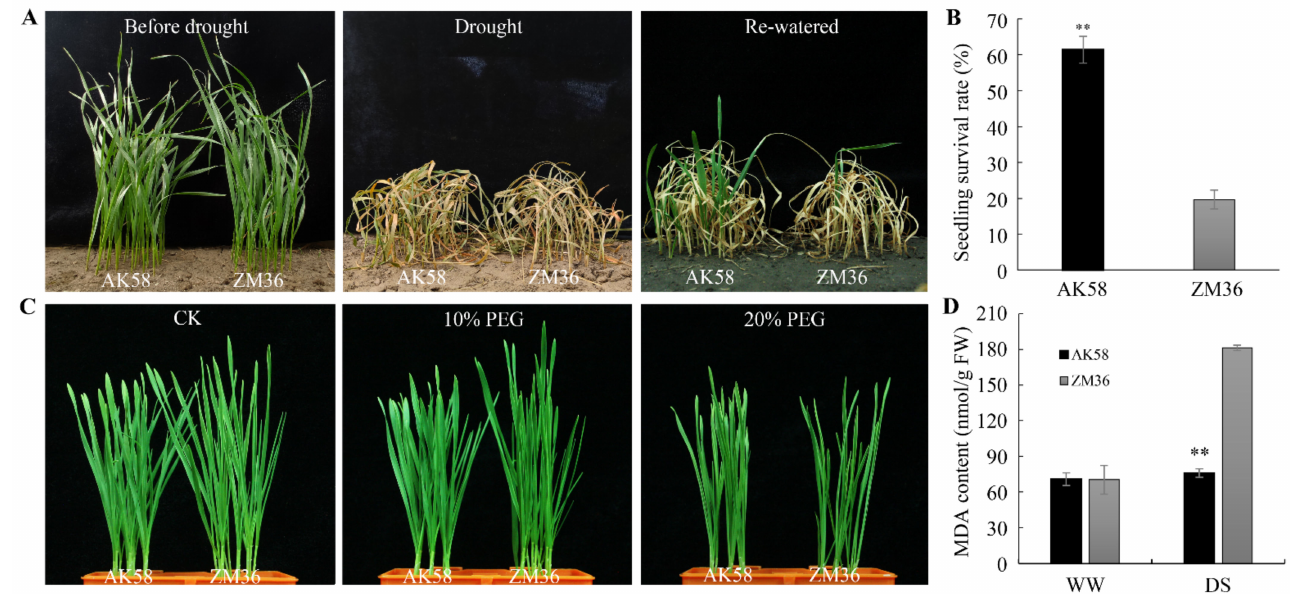
Figure 2. Seedlings of wheat cultivar AK58 were more tolerant to dehydration than ZM36. ( A ) Performance of AK58 and ZM36 seedlings before drought (left), drought stress (DS) for 18 days (middle) and re-watered for 11 days (right). ( B ) Seedling survival rates of AK58 and ZM36 exposed to drought stress followed by re-watering. ( C ) Seedlings of AK58 and ZM36 grown in hydroponic culture under water (CK) or PEG-6000 treatment for 36 h. ( D ) MDA contents in leaves of AK58 and ZM36 seedlings grown under well-watered (WW) and DS. Values represent means ± SE. **, t -test with p <